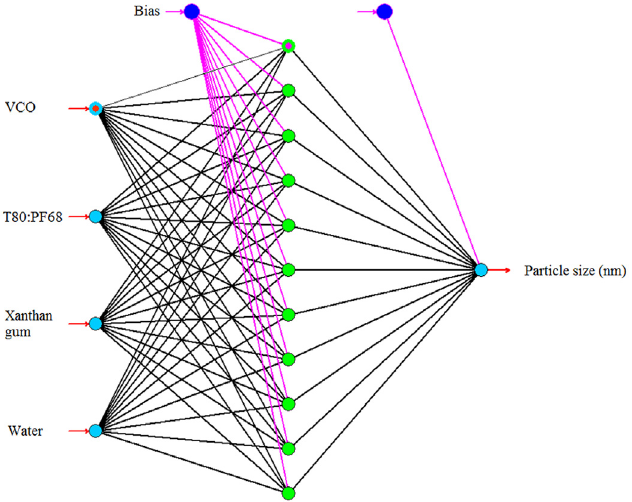
Fig 4. Schematic representation of a multilayer perception feedforward network of ANN based on GA consisting of four inputs, one hidden layer with 11 nodes and one output.